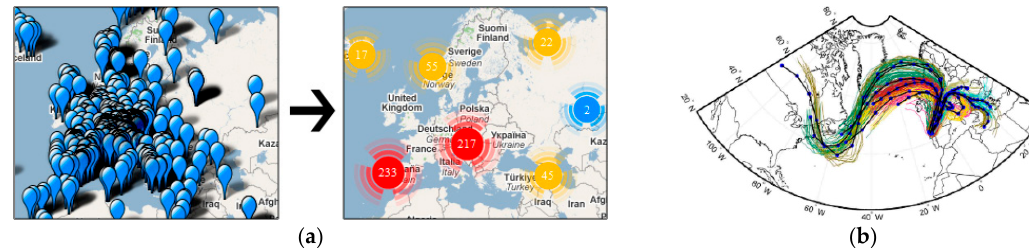
Figure 43. Clustering visualizations of different types of elements: ( a ) comparison of point elements before and after clustering [111]; and ( b ) clustered result of line elements [110].